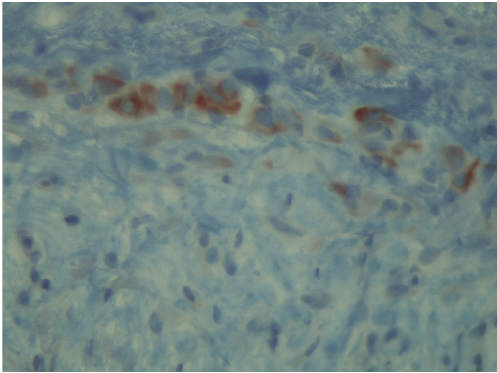
Figure 2: Positive immunohistochemical stain for CK 5/6 confirm- ing the presence of the above mesothelial cells ( ×